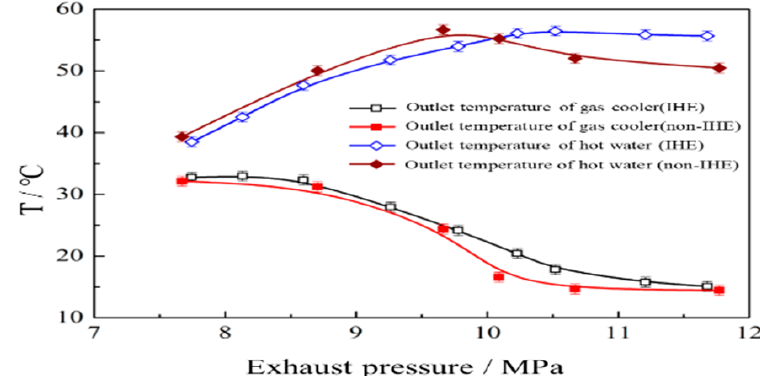
Figure 2. Variation of suction pressure and CO 2 mass flow.